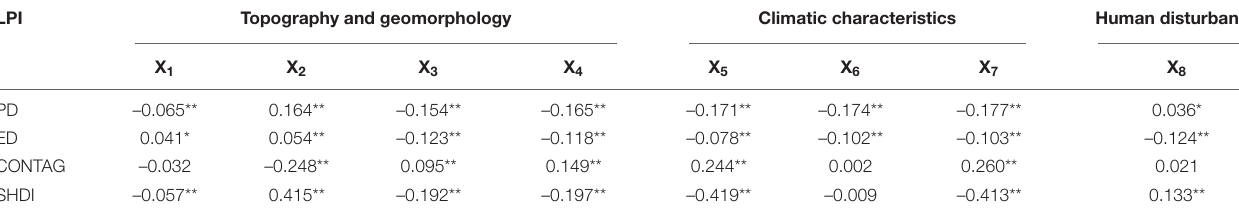
TABLE 6 | Bivariate correlations between landscape pattern indices (LPI) and driving factors at the landscape level. LPI Topography and